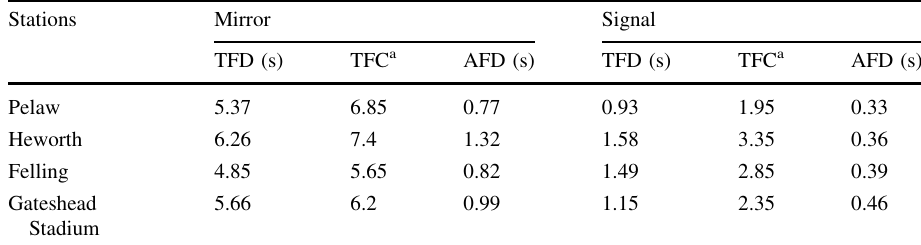
Table 4 Descriptive statistics for station departures (data related to mean values of 20 samples)